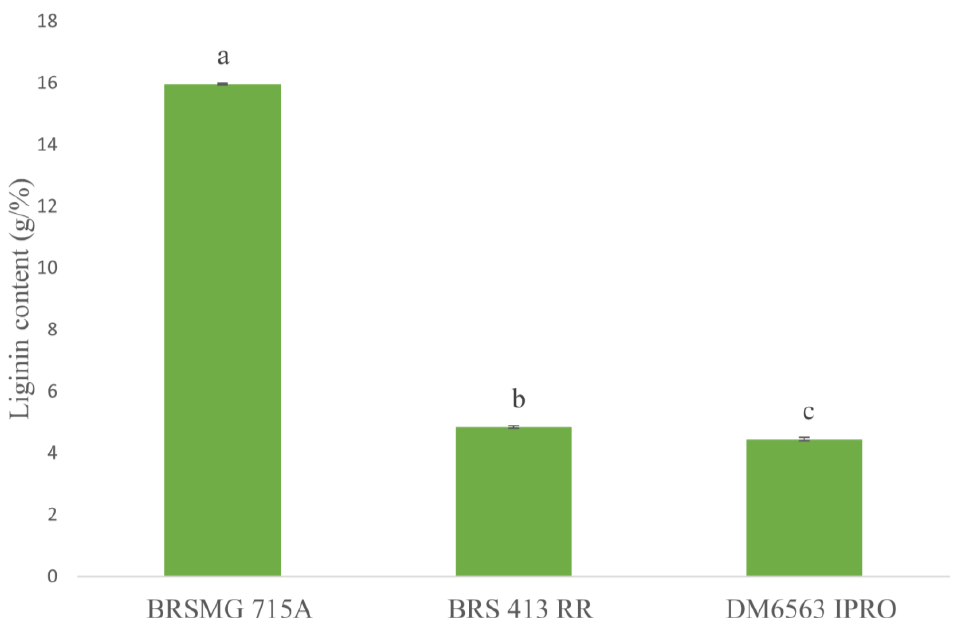
Figure 7. Lignin content in the soybean seed coats of the black seed coat cultivar BRSMG 715A and the yellow-coated cultivars BRS 413 RR and DM 6563 IPRO. Distinct letters show a significant difference via Tukey’s test ( p ≤